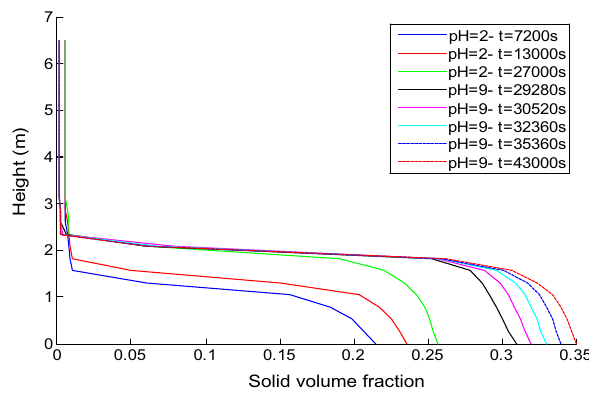
Fig. 4 Results of dynamic simulation of time-dependent variations of pH of input feed to the thickener of coal washing plant for the conditions: d 80 = 275 l m, F = 40 g/t, First pH 2 and then pH